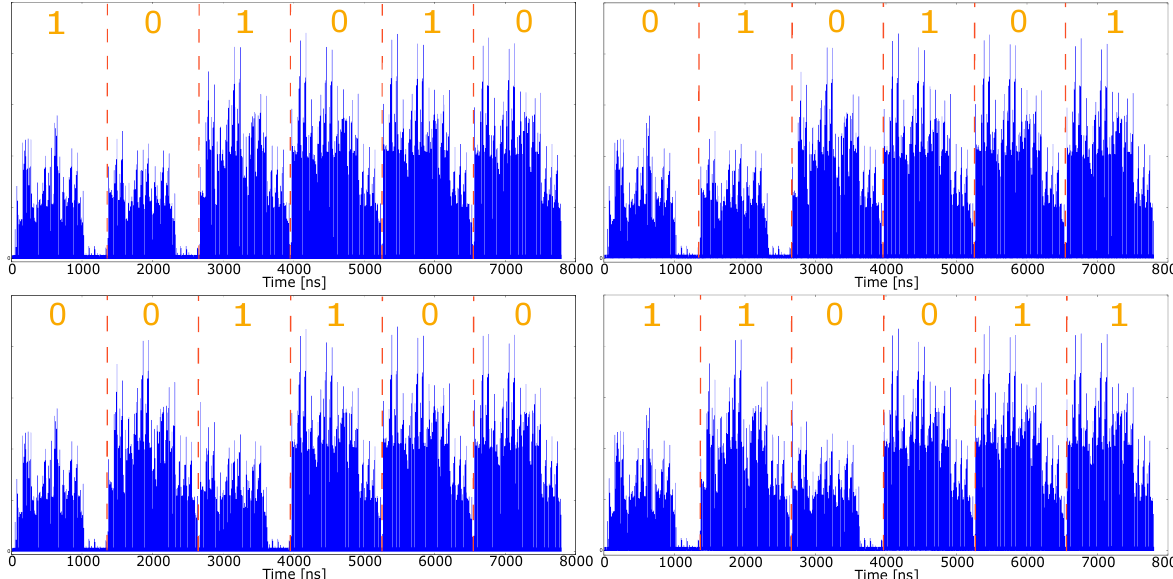
Figure 7. Acquired Power Traces for the Double-and-Add (Algorithm 1) where the least significant part of the key k is (LSB first): -1010101 ( top left ), -0101011 ( top right ), -0011001 ( bottom left ), -1100111 ( bottom right ).